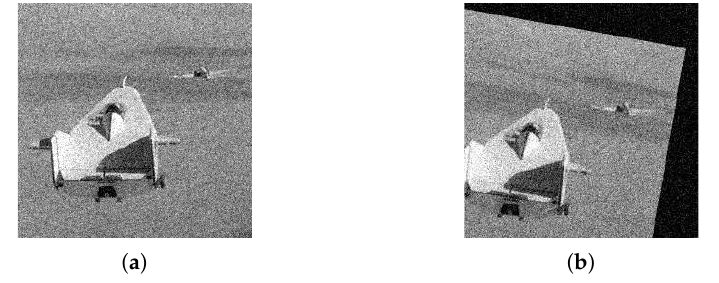
Figure 21. Lifting Body image pair. ( a ) Reference image. ( b ) Sensed image.